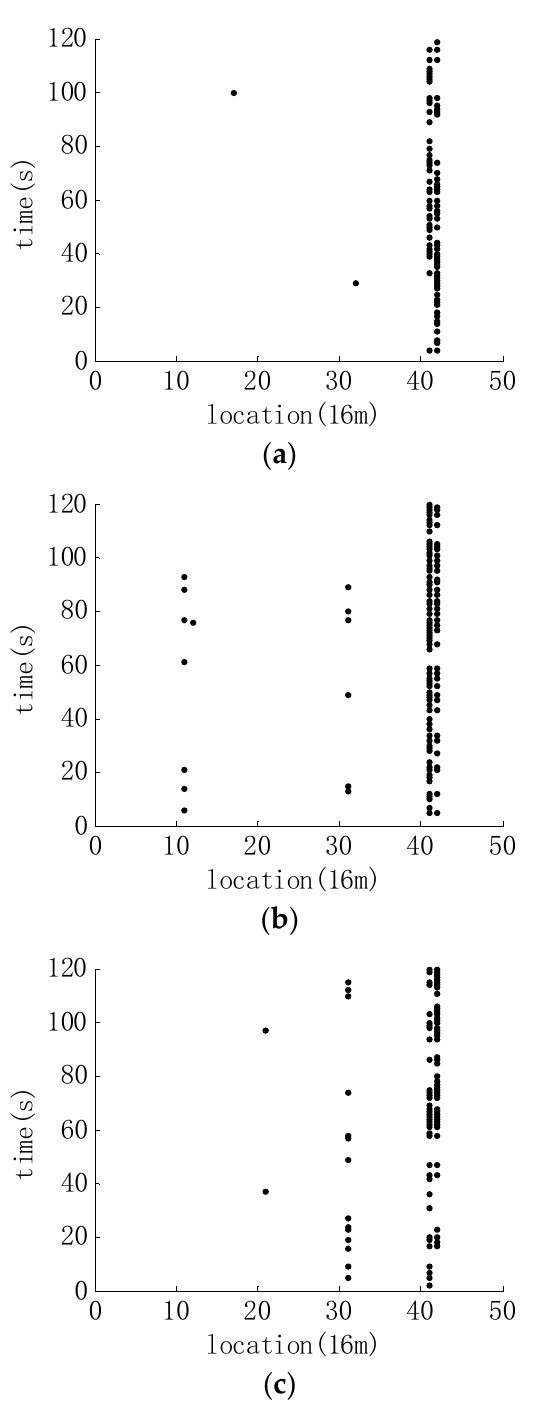
Figure 12. The detection results of mechanical picking signals. ( a ) The first group of mechanical picking signals; ( b ) The second group of mechanical picking signals; ( c ) The third group of mechanical picking signals.